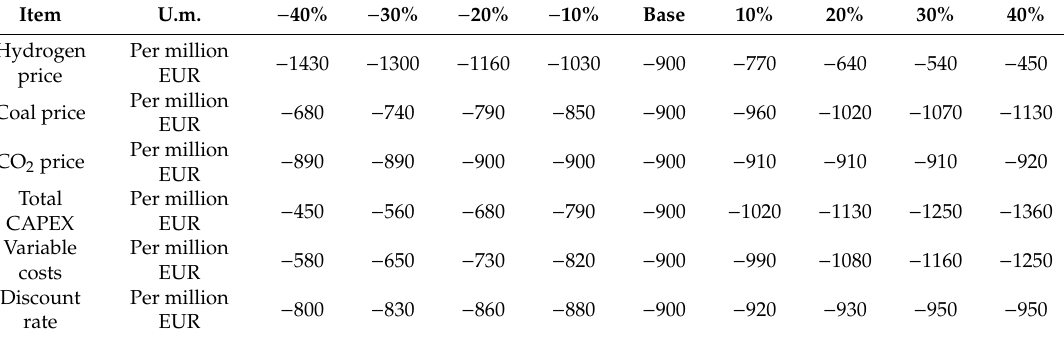
Table 12. Sensitivity analysis for lignite gasification w / CCS (L_H2_1).